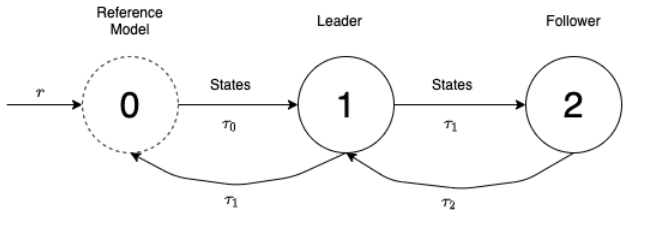
Figure 1. Communication graph of multi-agent